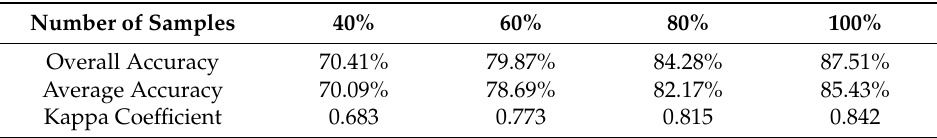
Table 3. Tree species classification accuracy in Res-UNet (Linear interpolation + CRF) networks with di ff erent training sample